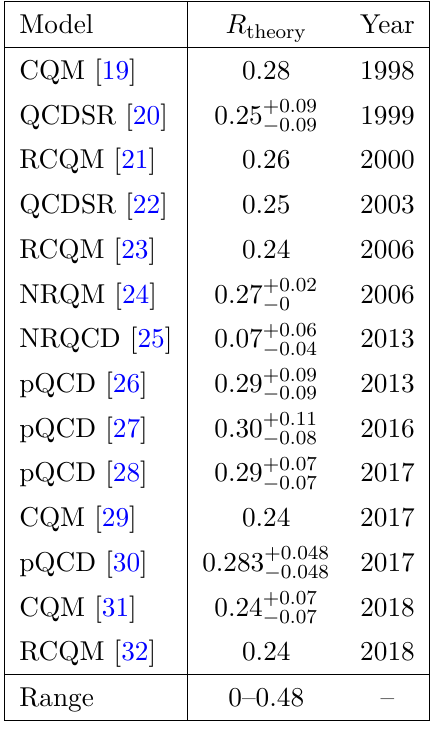
Table 1 . Model predictions of R ( J/ψ ) classified by method, which are abbreviated as: constituent quark model (CQM), relativistic quark model (RCQM), QCD sum rules (QCDSR), nonrelativistic quark model (NRQM), nonrelativistic QCD (NRQCD), and perturbative QCD calculations (pQCD). Setting t = t , we see that F ( t ) = ( M − m ) f ( t ). In this decomposition, the − 1 − − constraint A (0)= A (0) reads F (0) = 1 ( M 2 − m 2 ) F (0). The differential cross section 3 0 1 2 2